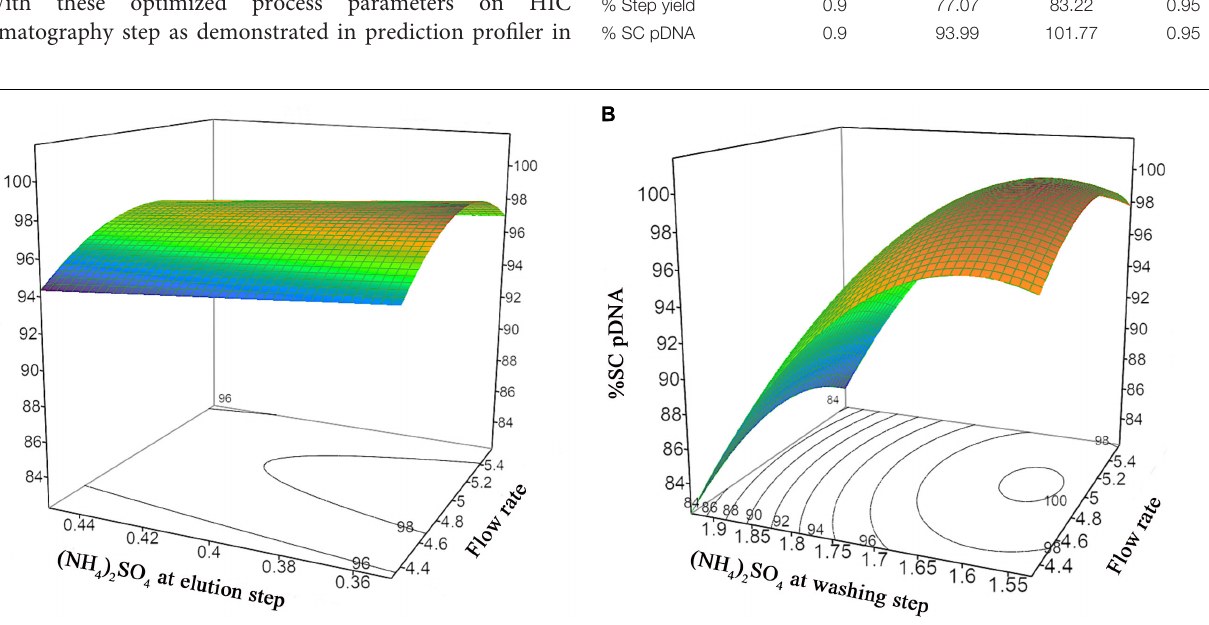
FIGURE 4 | Response surface prediction for %SC pDNA with (A) (NH 4 ) 2 SO 4 concentration at washing step and flow rate, (B) (NH 4 ) 2 SO 4 concentration at elution step and flow rate.